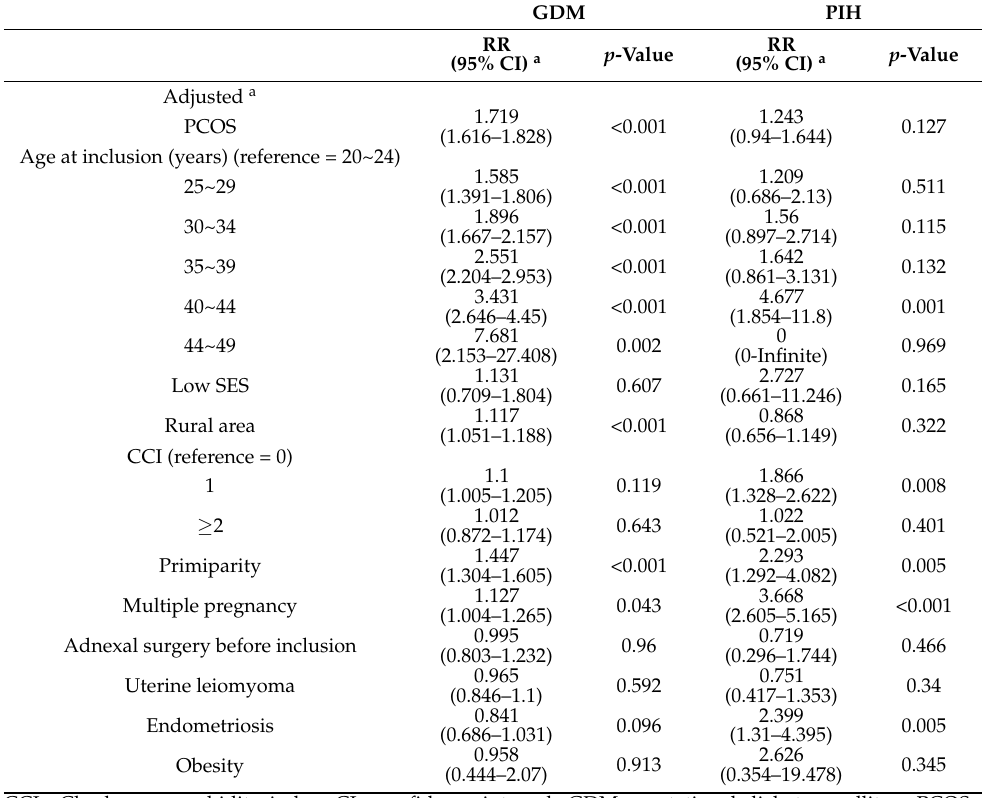
Table 3. Relative risks for gestational diabetes or pregnancy-induced hypertension in women with and without